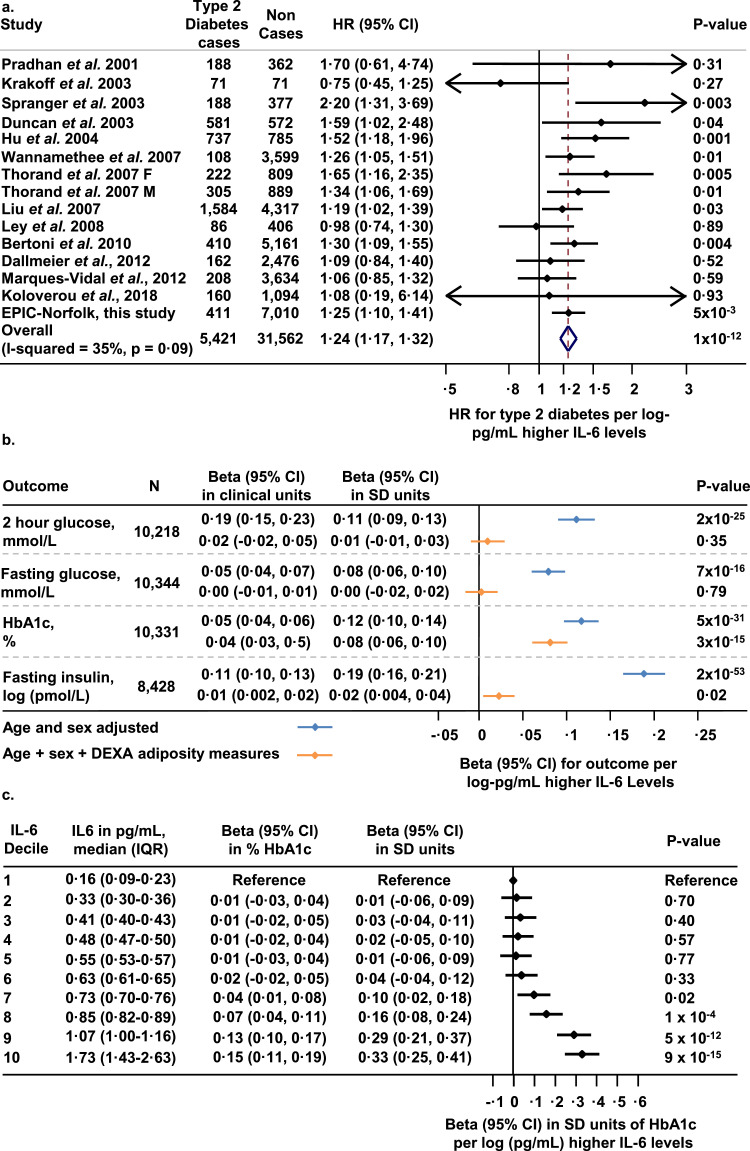
Association of IL-6 levels with type 2 diabetes and glycaemic traits. Panel a. Association between higher IL-6 levels and type 2 diabetes in 15 prospective studies. The study-specific estimates of association (here labelled “Hazard Ratio” (HR)) and their 95% confidence intervals are shown per log-pg/mL higher IL-6 levels. Thorand et al.·, 2007 is depicted with sex-stratified estimates as different IL-6 quantitation methods were used in men and women. Panel b. Association between IL-6 levels and glycaemic traits in the Fenland study. Estimates are presented in standard deviation and clinical units of continuous outcome per log-pg/mL higher IL-6 levels. Panel c. Association between IL-6 levels (in deciles) and HbA1c.Estimates are shown for a given decile compared to the bottom decile (reference group) and are adjusted for age, sex, DEXA adiposity measures and iron-related traits. Abbreviations: HR, hazard ratio; CI, confidence interval; F, females; M, males; pg, picograms; mL, millilitres; L, litres, mmol; millimoles; pmol, picomoles; HbA1c, glycated hemoglobin; DEXA, dual-energy X-ray absorptiometry; IQR, inter-quartile range; SD, standard deviation.